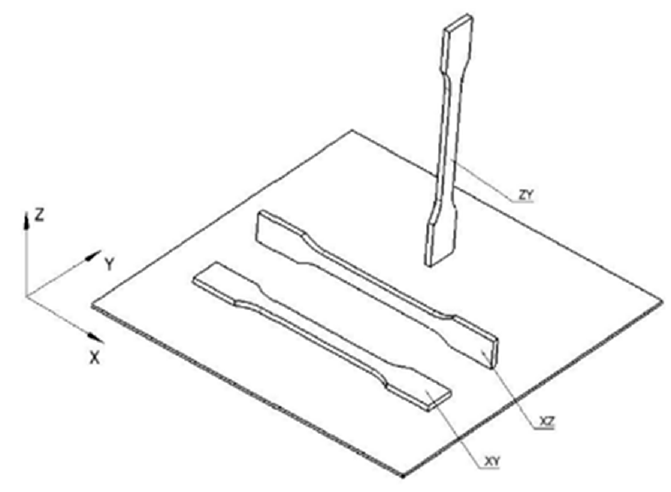
Figure 3. Printing directions for the samples used in tensile